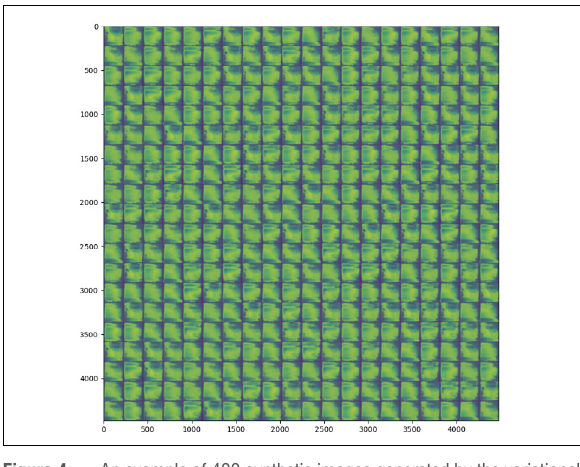
Figure 4: An example of 400 synthetic images generated by the variational autoencoders trained on the single-cell fault images.